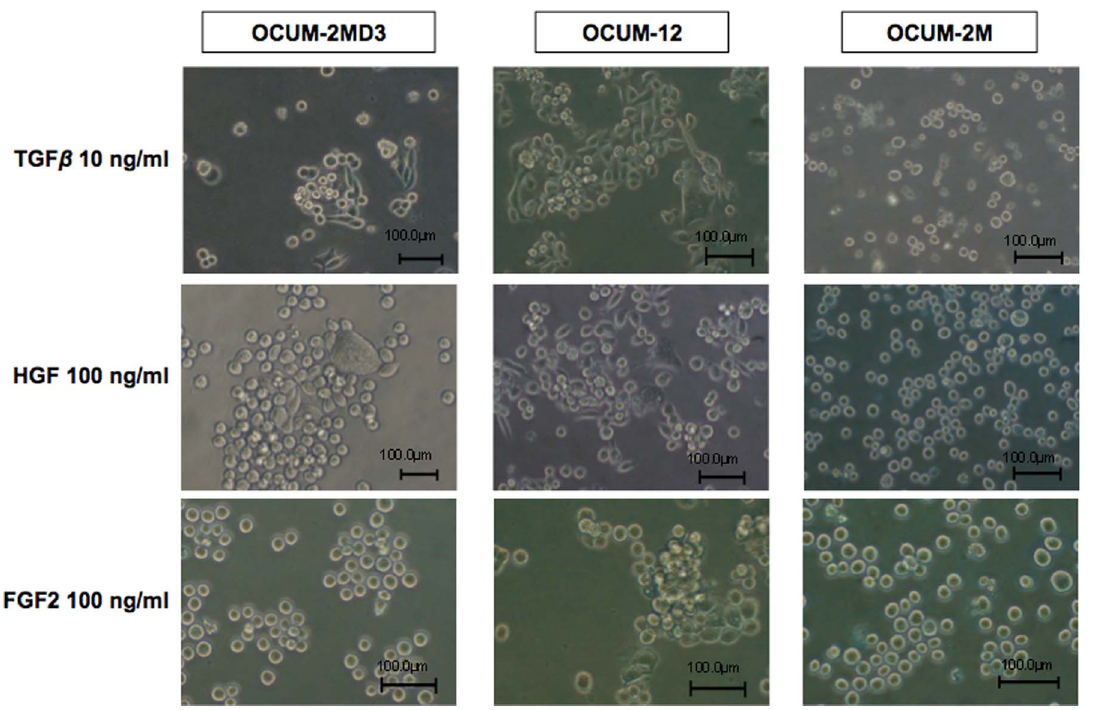
Figure 2. Effects of various growth factors on cancer cell morphology. Morphologic change was found in the presence of TGF b and HGF at 24 h of culture in OCUM-2MD3 and OCUM-12 cells, but not FGF2.